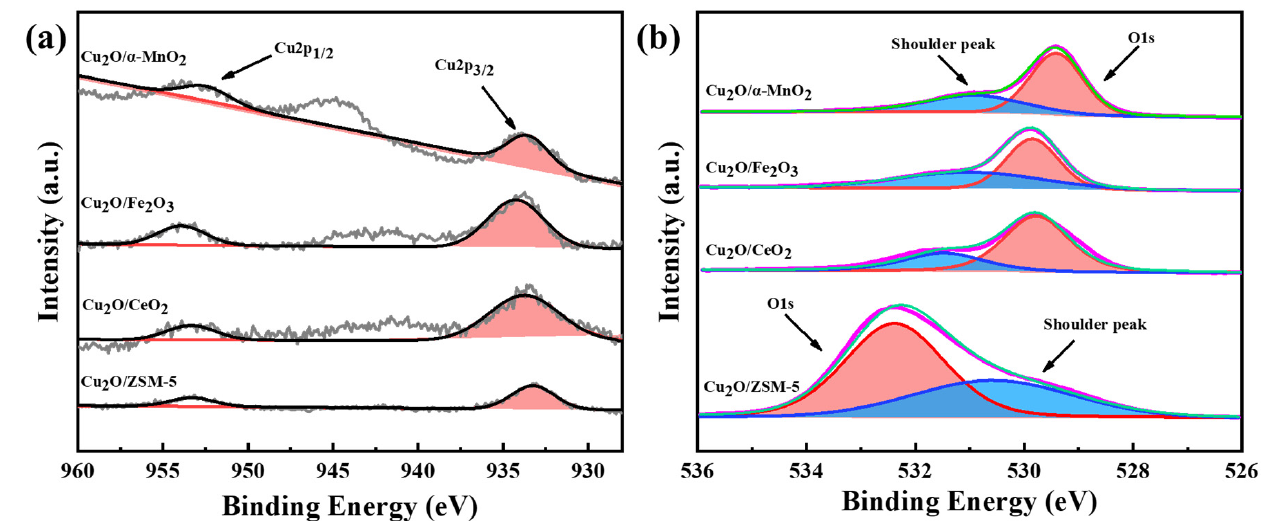
Figure 11. ( a ) Cu 2p and ( b ) O 1s XPS spectra of the as-prepared Cu 2 O/S (S = ZSM-5, CeO 2 , α -MnO 2 , and Fe 2 O 3 ) catalysts. Table 3. O 1s peak area of the as-prepared Cu 2 O/S (S = ZSM-5, CeO 2 , α -MnO 2 , and Fe 2 O 3 ) Cu 2 O/ α